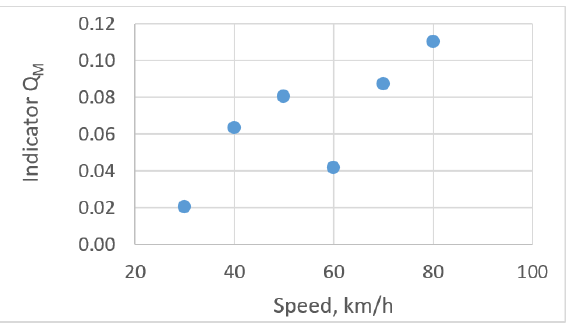
Figure 24. Vertical force mean values of loaded goods wagon.